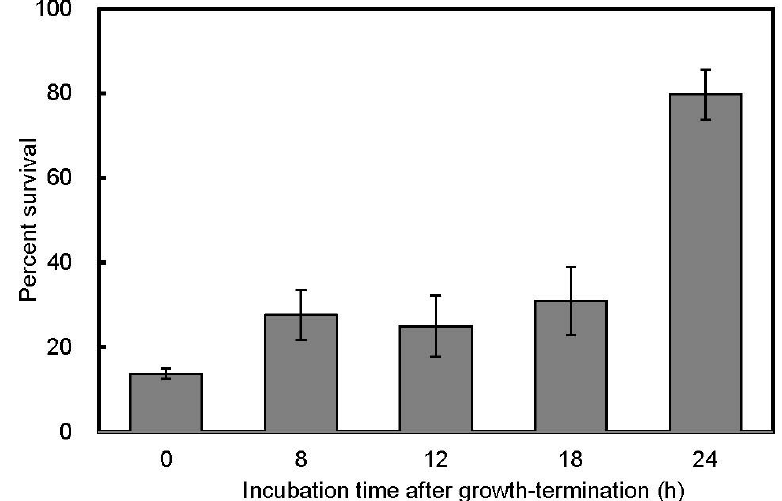
Figure 2. Changes in salt stress tolerance of starved cells in the light. As shown in Figure 1, the percent survival after exposure to 2.5 M NaCl stress were determined for starvation-initiated cells (i.e., 0 h starved cells) and anaerobic starved cells incubated for 8 h, 12 h, 18 h, and 24 h in the light. Error bars indicate standard deviation of three biological replicates.